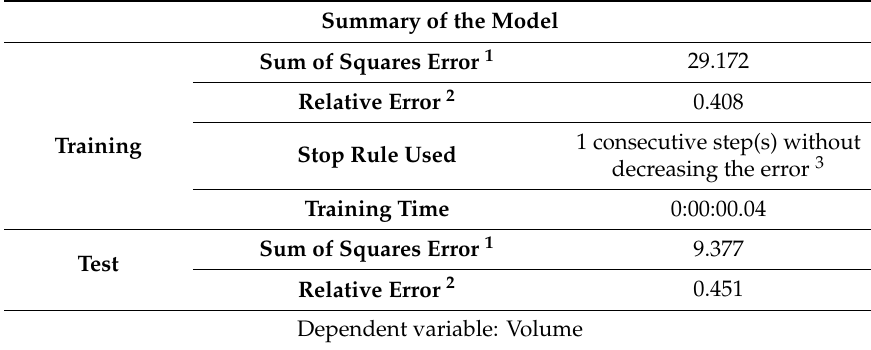
Table 3. Adjustment of the neural network Volume.